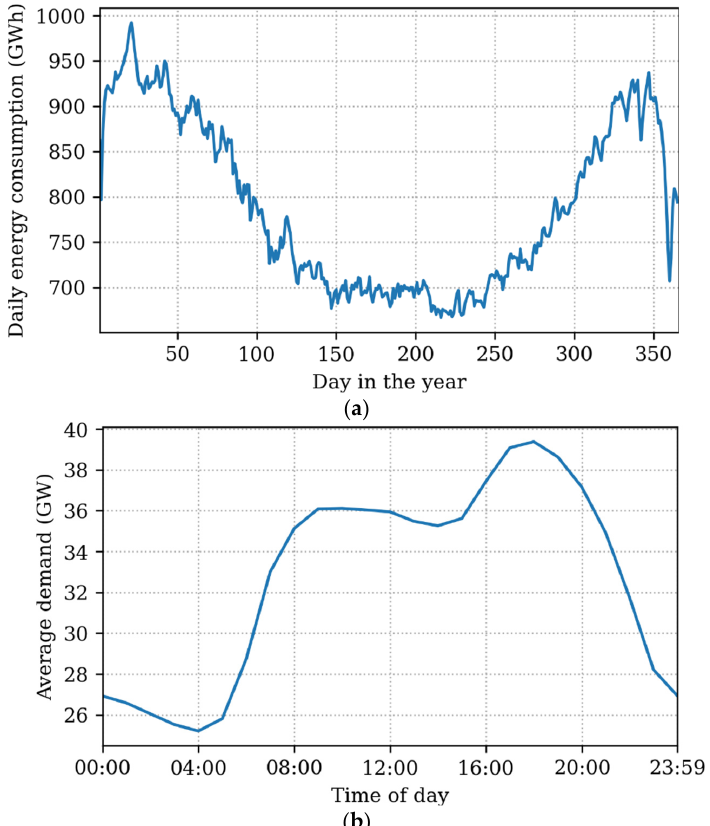
Figure 2. Illustration of the electricity demand data used in the simulations: ( a ) daily electricity consumption throughout the year; ( b ) electricity demand profile on the “average day”.